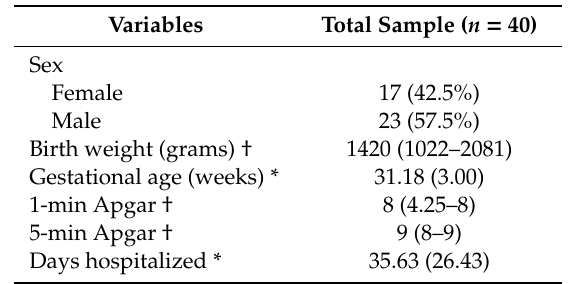
Table 1. Sample characterization.